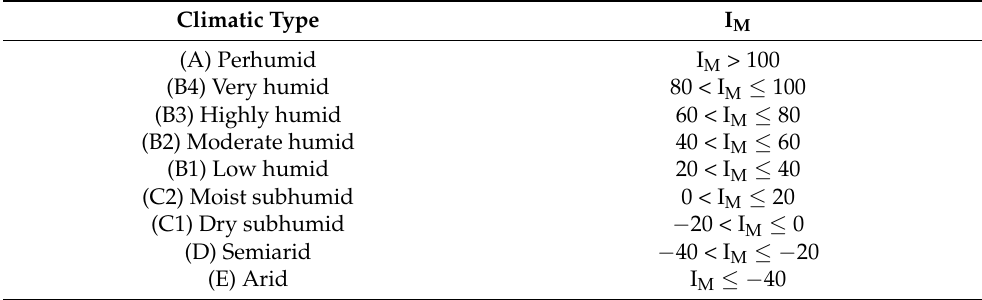
Table 2. Climatic types and the corresponding ranges of I M . Climatic